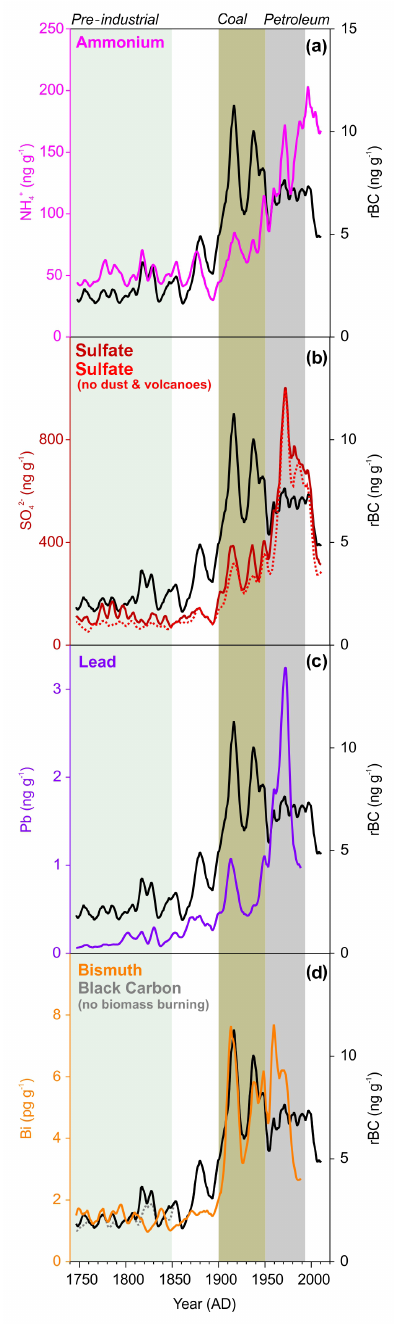
Figure 4. Colle Gnifetti rBC record (black) compared with (a) am- monium (NH + ), (b) total sulfate (SO 2 − ) and sulfate corrected for 4 4 contributions from volcanic emissions and Saharan dust (dotted line), (c) lead (Pb), and (d) bismuth (Bi) together with rBC corrected for biomass burning contributions (BC no BB ; grey dotted line). All records are 11-year filtered. Marked are time periods dominated by pre-industrial emissions (AD1741–1850), coal burning (AD1901– 1950) and petroleum burning emissions (AD1951–1993), respec-